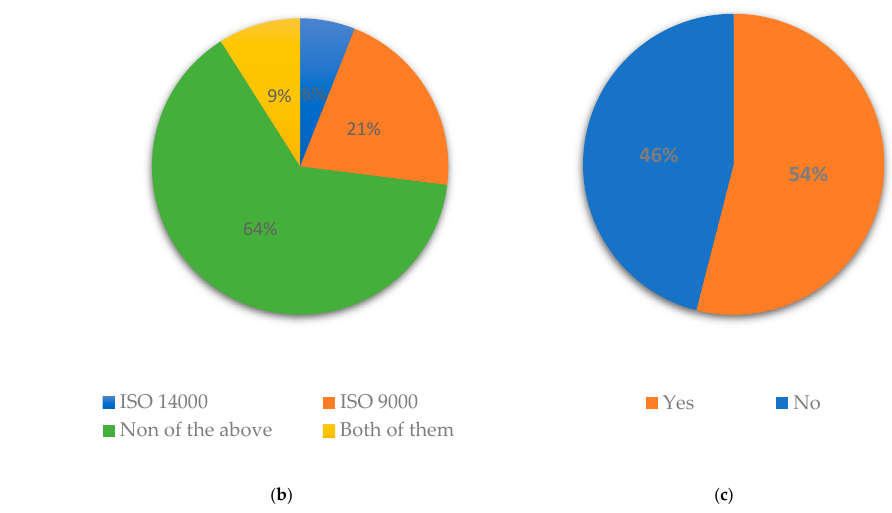
Figure 3. The structure of the surveyed population: ( a ) the number of employees; ( b ) held ISO certificates; ( c ) the internal regulations related to waste reduction.